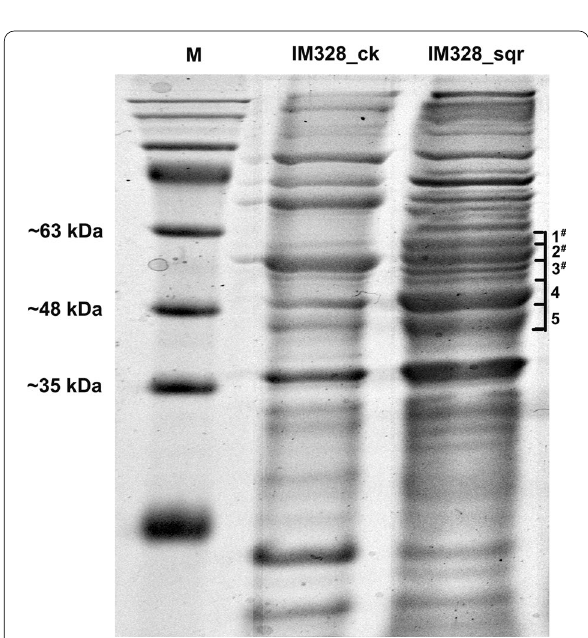
Fig. 5 SDS-PAGE of IM328_ck and IM328_sqr. Stacking gel of 5 % polyacrylamide (pH 6.8) and separating gel of 12 % polyacrylamide (pH 8.8) were used, and 20 µL protein extracts were loaded for electrophoresis at the low temperature. The gels containing possible target bands of similar molecular weight were recovered for mass spectrometry, and the samples were numbered 1 to 5, of which samples 1, 2, and 3 (marked by #) contained peptide fragments of interest Sqr. The details are summarized in Additional file 1: Table S3. IM328_ck: IM328_ck strain as control; IM328_sqr: IM328_sqr strain; M: protein